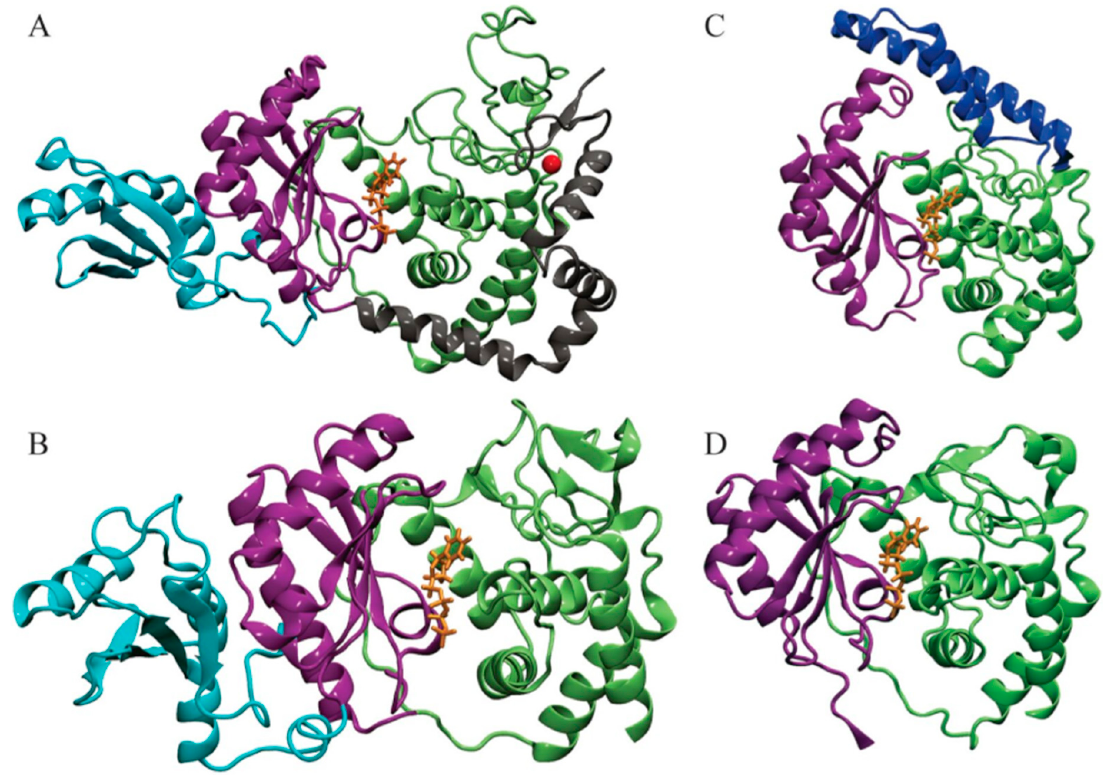
Figure 1. Structures of four T. brucei terminal uridylyl transferases (TUTases) shown in ribbons. ( A ) TbRET1; ( B ) TbRET2; ( C ) TbMEAT1; ( D ) TbTUT4. Enzymes are colored according to the